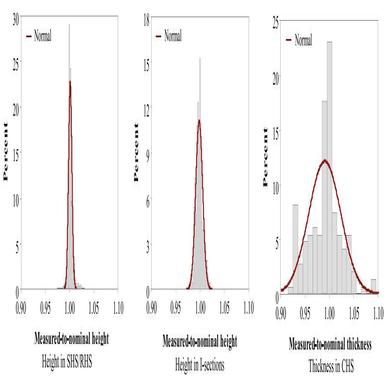
Histograms of cross-section dimensions for different stainless steel section types.